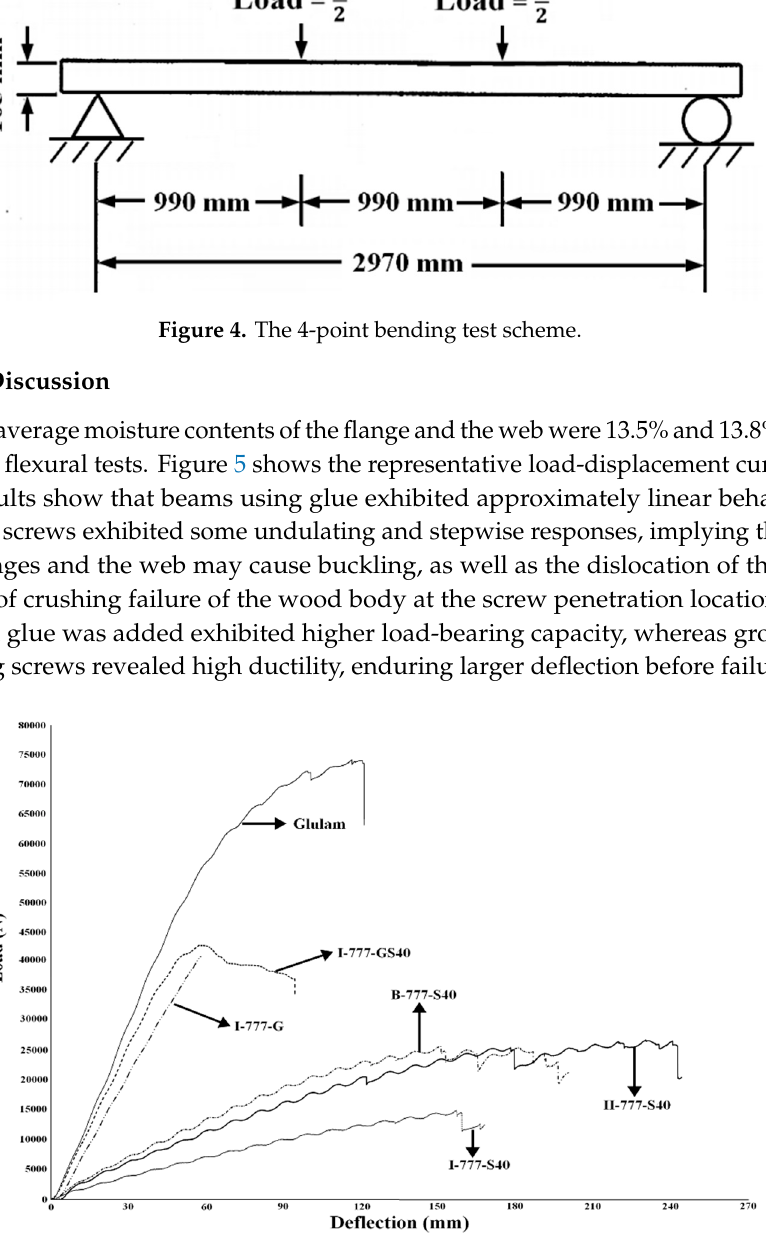
Figure 5. Load-deflection curves of various groups.